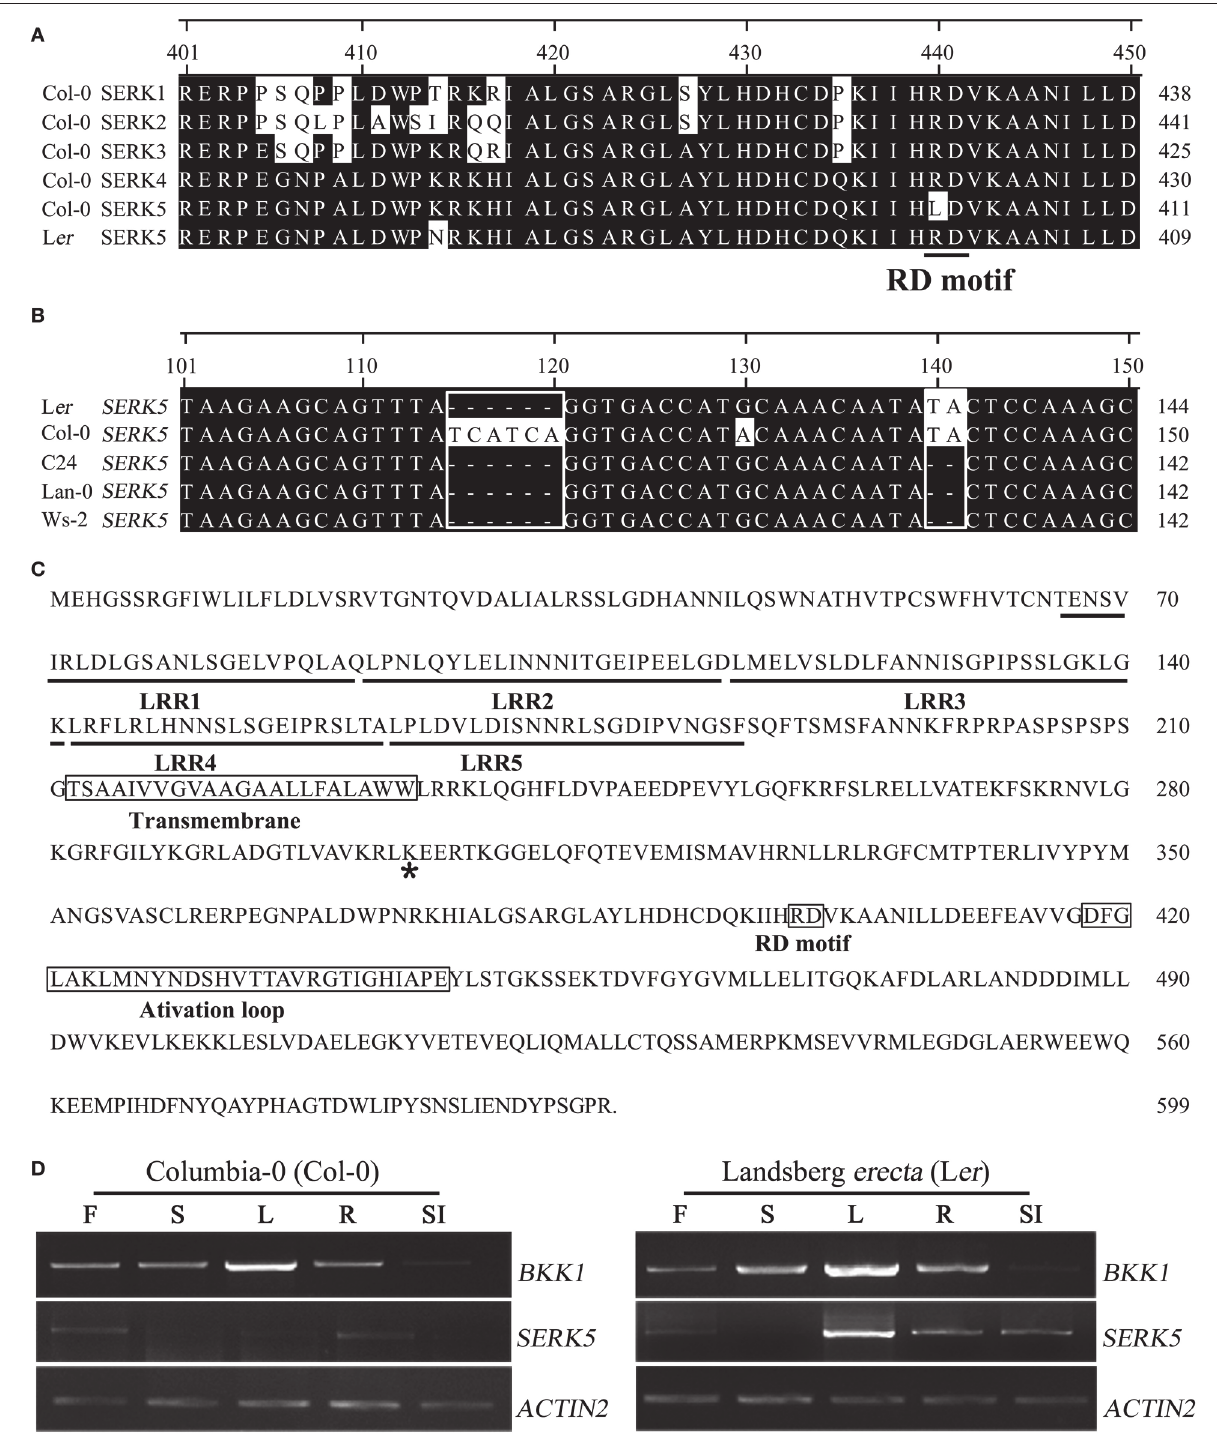
FIGURE 1 | SERK5 in Landsberg erecta (L er ) ecotype encodes a LRR-RLK with a normal RD motif. (A) Amino acid sequence alignment (position 401–450) of SERK1-5 in Col-0 ecotype and SERK5 in L er ecotype. SERK5-L er contains a normal RD motif. R is substituted by L at position 401 in SERK5-Col. (B) cDNA sequence alignment (position 101–150) of SERK5 in L er , Col-0, C24, Lan-0, and Ws-2. SERK5 in Col-0 contains extra six nucleotides in alignment position 115–120. SERK5 in C24, Lan-0, and Ws-2 contains two-nucleotide (TA) deletion at alignment position 140–141. (C) Full protein sequence of SERK5 in L er . Asterisk mark indicates the conserved lysine (K) in ATP binding domain. (D) Expression levels of BKK1 and SERK5 in Col-0 (left) and Landsberg erecta (L er ) (right) ecotype are shown in all plant tissue. Semi-quantitative RT-PCR was carried out with RNA isolated from the 4 weeks old Col-0 and L er ecotype Arabidopsis grown in soil. The PCR amplification cycles for BKK1 , SERK5 and quantitative control ACTIN2 , are 30, 30, and 19, respectively. F, flowers; S, stems; L, rosette leaves; R, roots; SI, siliques.